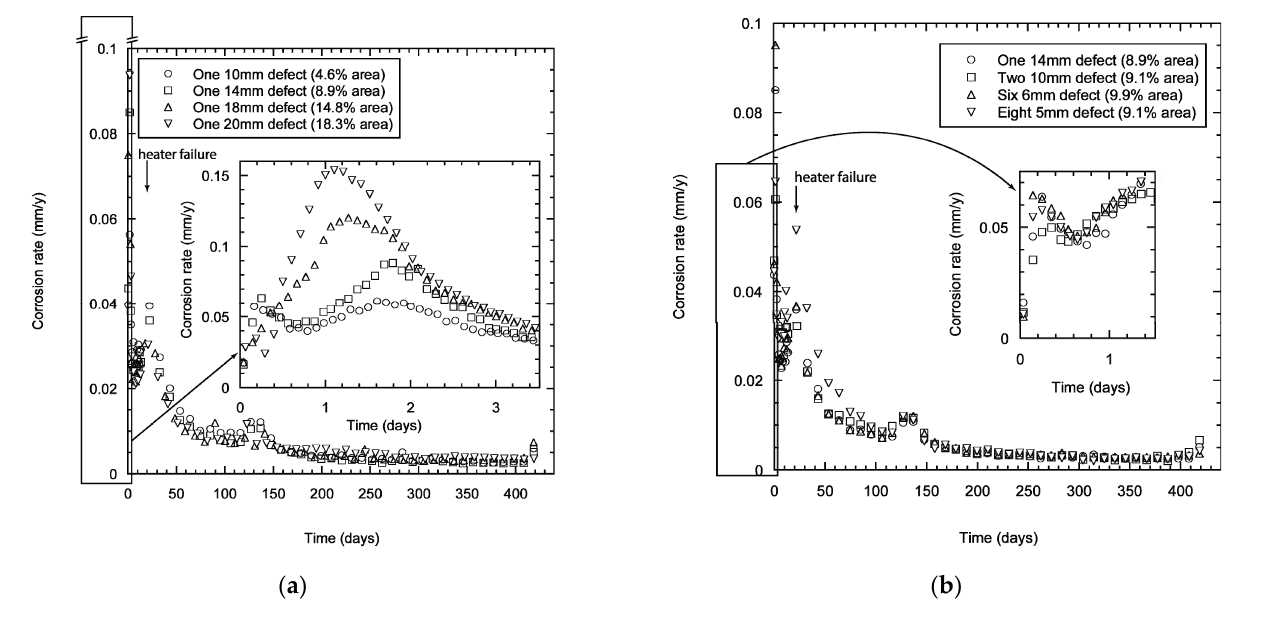
Figure 4. Calculated corrosion rate of TSA specimens showing the effect of damage size ( a ), and distribution ( b ). The measurements were carried out in synthetic seawater (ASTM D1141) at 25 °C.